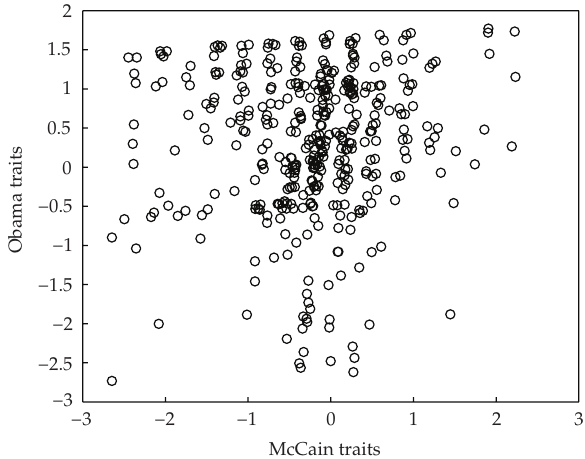
Figure 7: Scatterplot of Obama and McCain traits for Obama